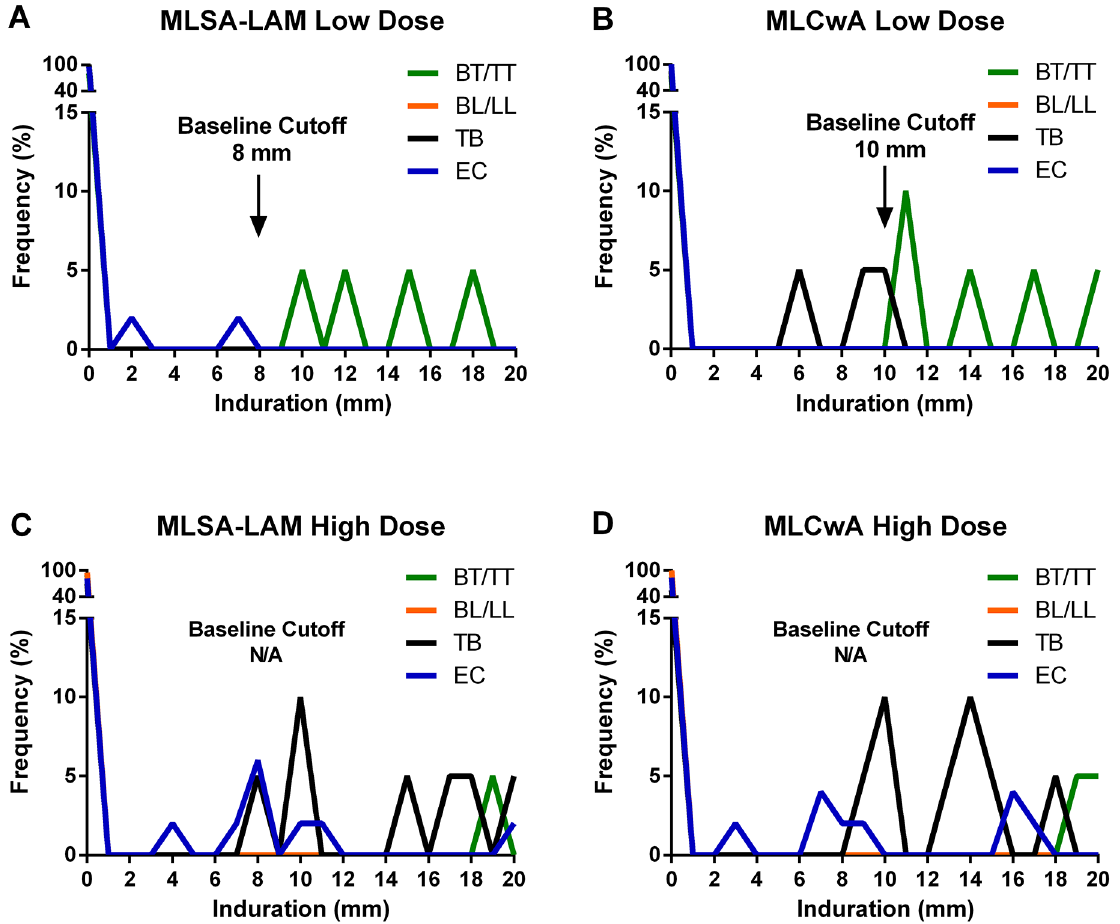
Figure 4. Distribution frequency of induration. Frequency distribution graphs were used to establish cut off points for each skin test antigen at each dosage tested: A) MLSA-LAM low dose, B) MLCwA low dose, C) MLSA-LAM high dose, D) MLCwA high dose. Frequency of induration reaction (mm) of EC and TB groups were graphed against BT/TT and BL/LL leprosy groups. The anti-mode between the control and leprosy patient group represents the cut off for each antigen and antigen dose.